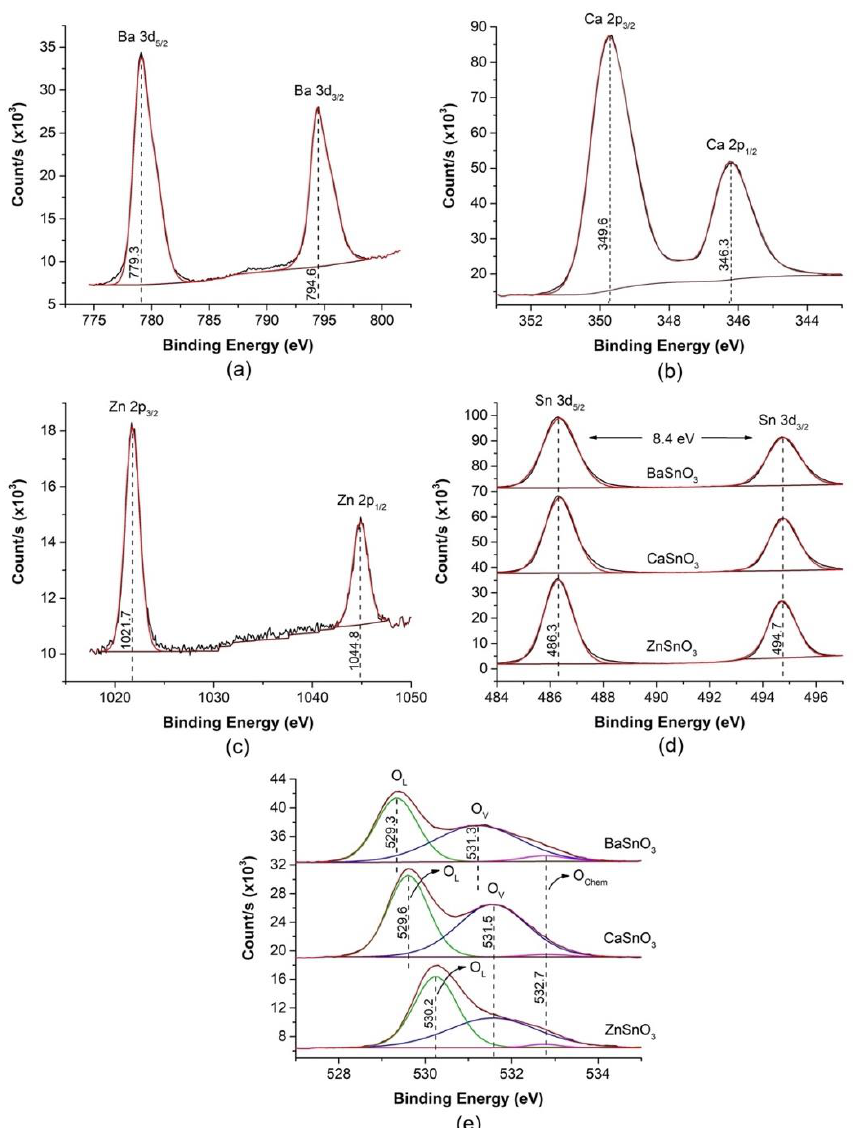
Figure 7. XPS spectra of the sintered ceramic bodies based on MSnO 3 perovskites (M = Ba, Ca, Zn): ( a ) Ba-3d, ( b ) Ca-2p, ( c ) Zn-2p, ( d ) Sn -3d, and ( e ) O-1s (O L : lattice oxygen, O V : oxygen vacancies and O Chem : chemosorbed oxygen species).